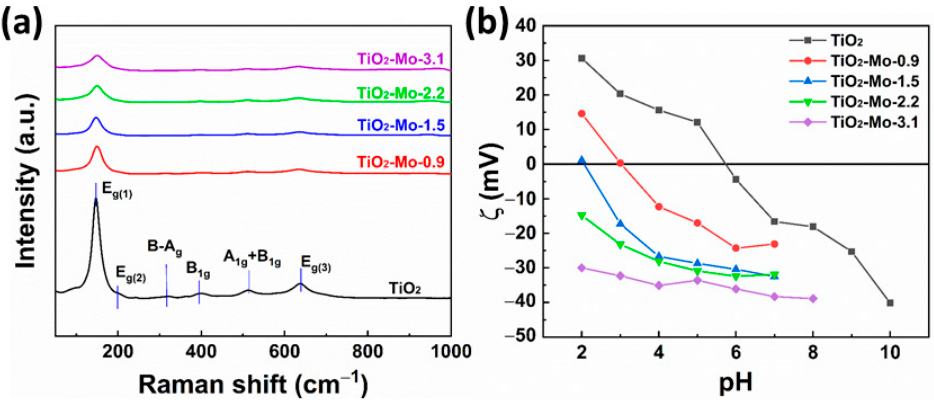
Figure 6. ( a ) Raman spectra of investigated TiO 2 -based materials and ( b ) the variation of zeta-potential of investigated nanomaterials with the pH.